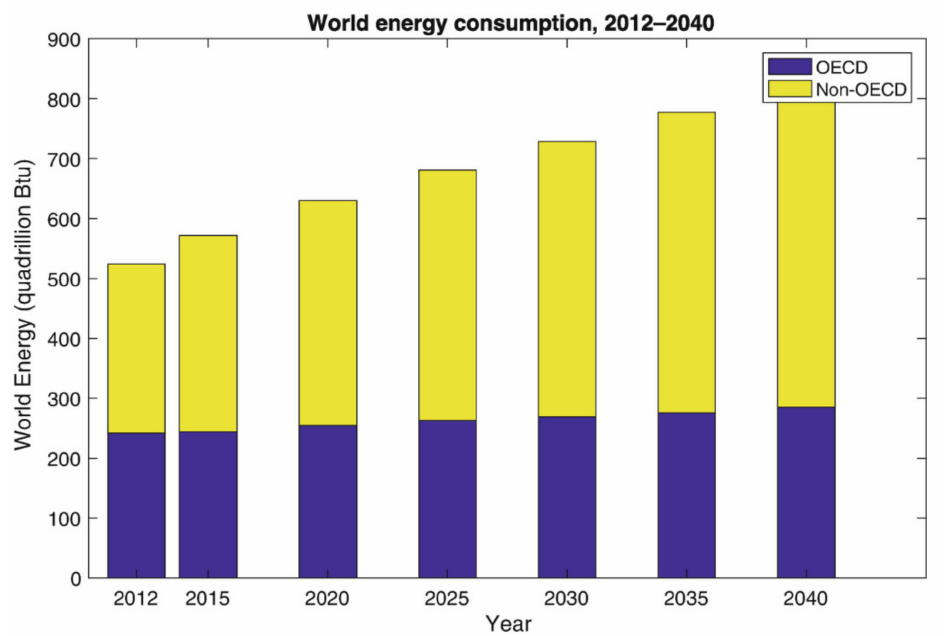
Figure 2. Projected growth in world energy demands up to 2040, (https://link.springer.com/chapter/ 10.1007/978-3-030-10427-6_1) (12 February